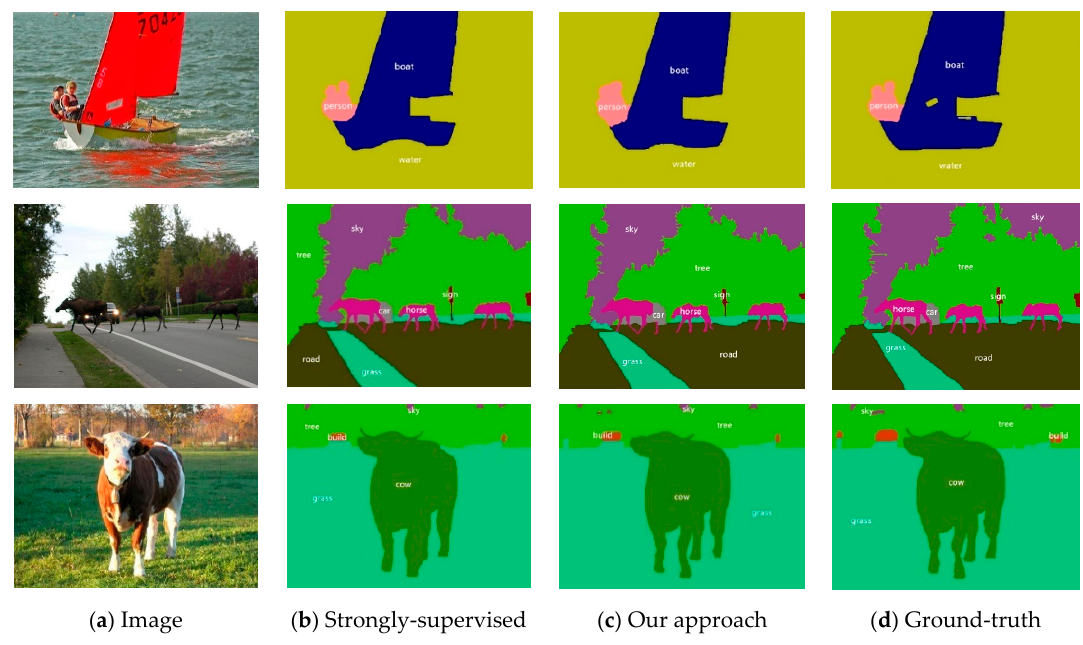
Figure 12. Results on PASCAL-CONTEXT dataset.